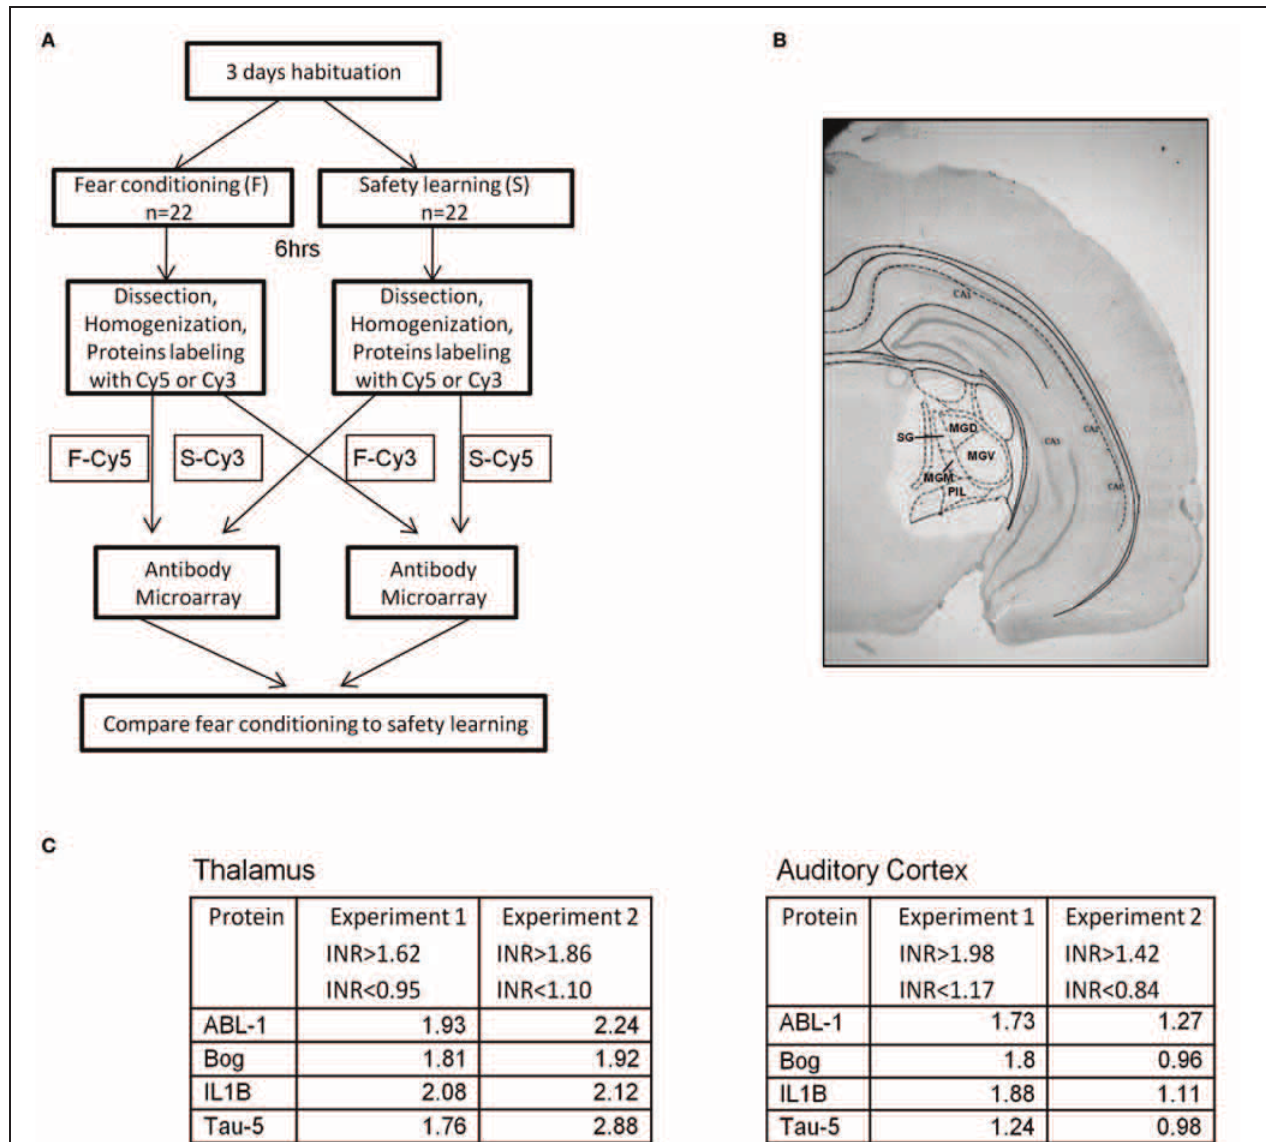
FIGURE 2 | Proteins levels in thalamus are lower in unpaired compared to paired trained rats. (A) Rats were trained for fear conditioning [ F ; paired CS-US presentation ( n = 22)] or safety learning [S; unpaired CS-US presentation ( n = 22)]. Six hours after training the thalamus area, that includes the auditory and noniceptive areas was dissected, proteins were extracted, labeled, and subjected to antibody microarray. Differences between the level of specific proteins in the fear conditioning and safety learning groups were evaluated. (B) Representative brain section showing dissection of thalamus. (C) The